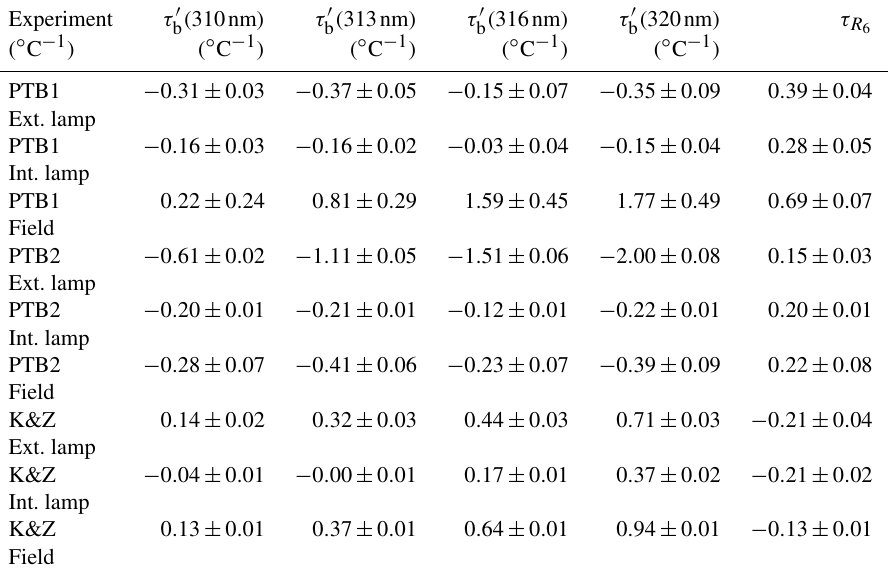
Table 2. Temperature coefficients obtained from the linear regression of the mean values for each temperature, for slits 2, 3, 4 and 5 retrieved from Brewer measurements relative to slit 1 ( τ (cid:48) ) and temperature coefficient for R 6 ( τ R ). Rows are grouped in three blocks representing the b 6 tree experiments (PTB1, PTB2 and K&Z). For each experiment, results from external (top row) and internal (middle row) lamp measurements in the temperature chamber and derived from field data (bottom row) are